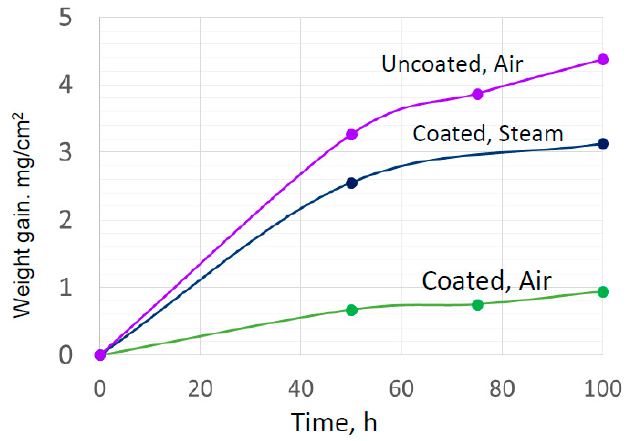
Figure 4. Plots of cyclic oxidation weight gain (mg/cm 2 ) vs. time (h) for a coated SiC heating element at 1427 ◦ C in air and in 90 vol.% H 2 O + 10 vol.% O 2 and an uncoated SiC heating element at 1427 ◦ C in